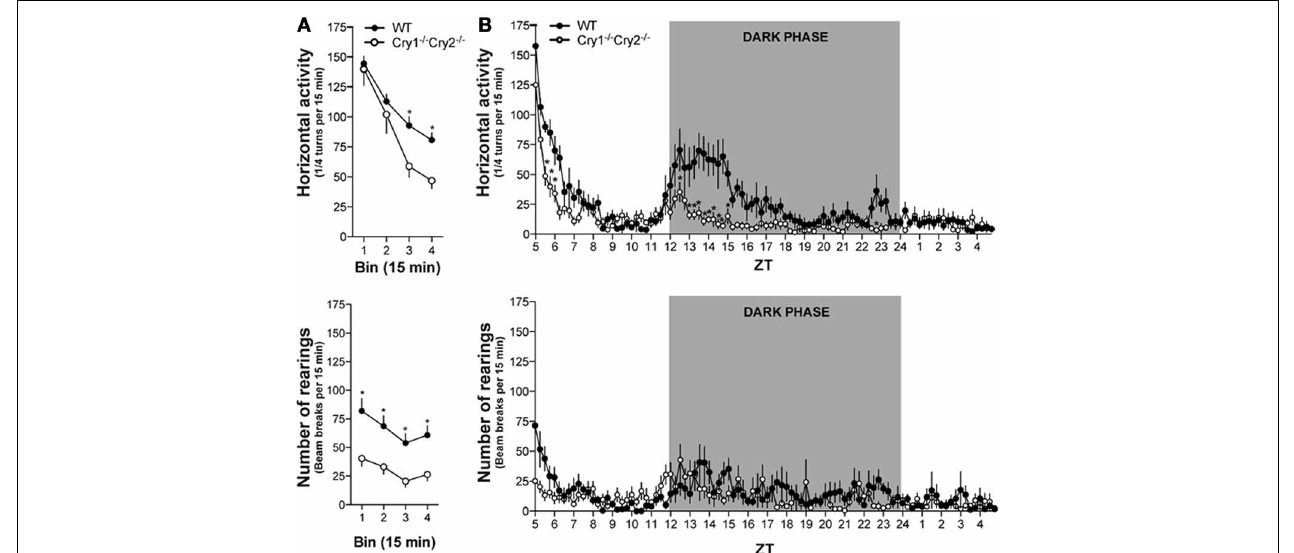
FIGURE 1 | Spontaneous locomotor activity in Cry1 − / − Cry2 − / − mice. (A) When exposed to an enclosed environment, horizontal activity (top panel) declined more rapidly [Genotype × Time: F ( 3 , 111 ) = 3 . 29, P = 0 .